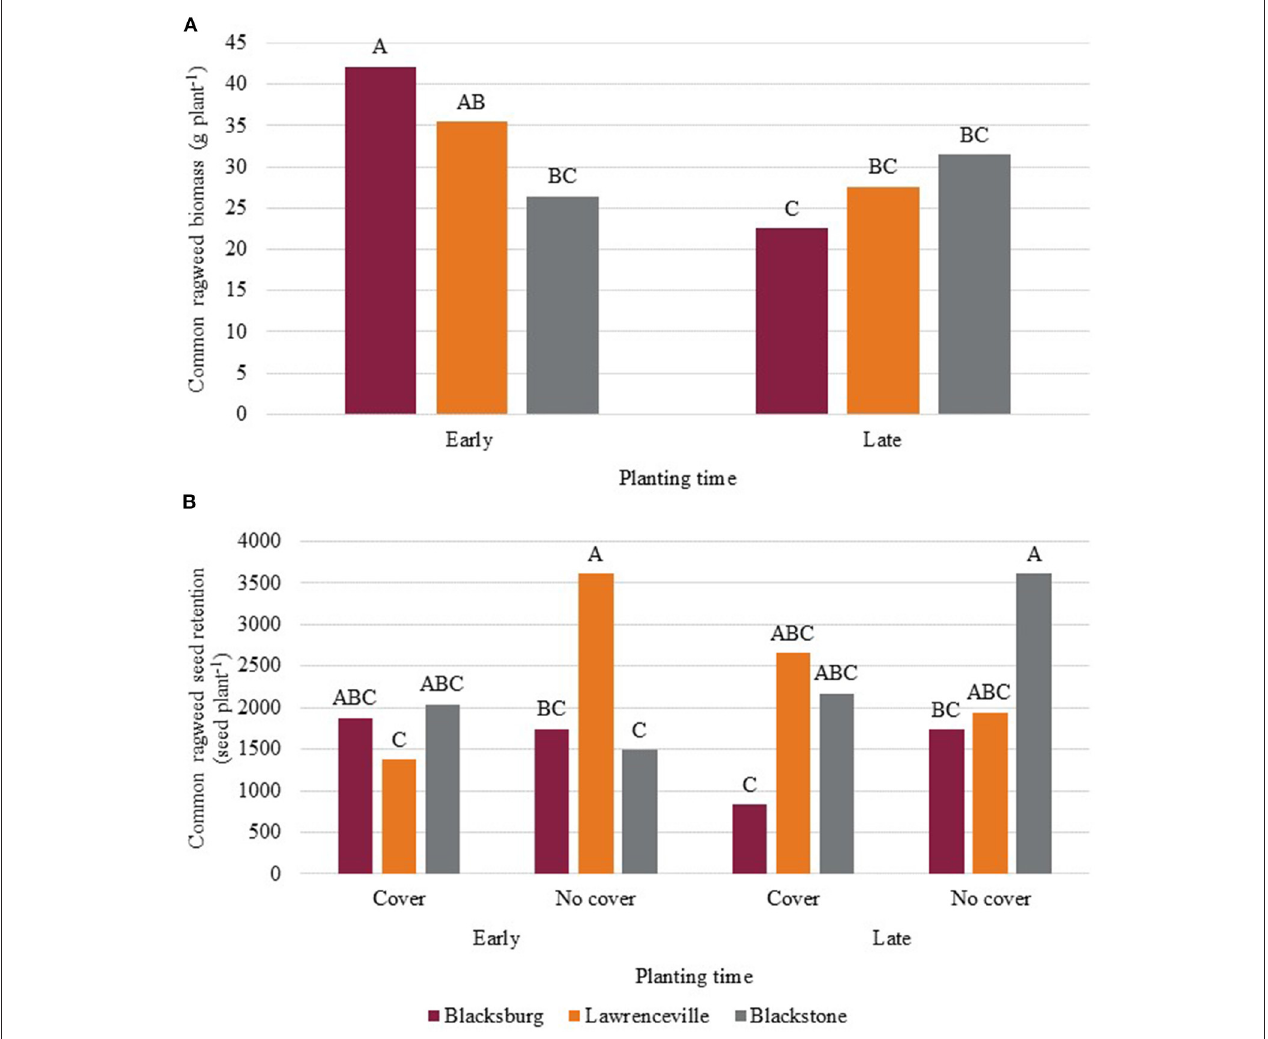
FIGURE 3 | (A) common ragweed biomass at soybean harvest by location and planting time for the first year of the field experiment and (B) common ragweed seed retention at soybean harvest by location, planting time, and cover (cereal rye for early planting and winter wheat for late planting) for the first year of the field experiment. Means are considered statistically different when they do not share a letter according to Fisher’s Protected LSD ( P = 0.05)